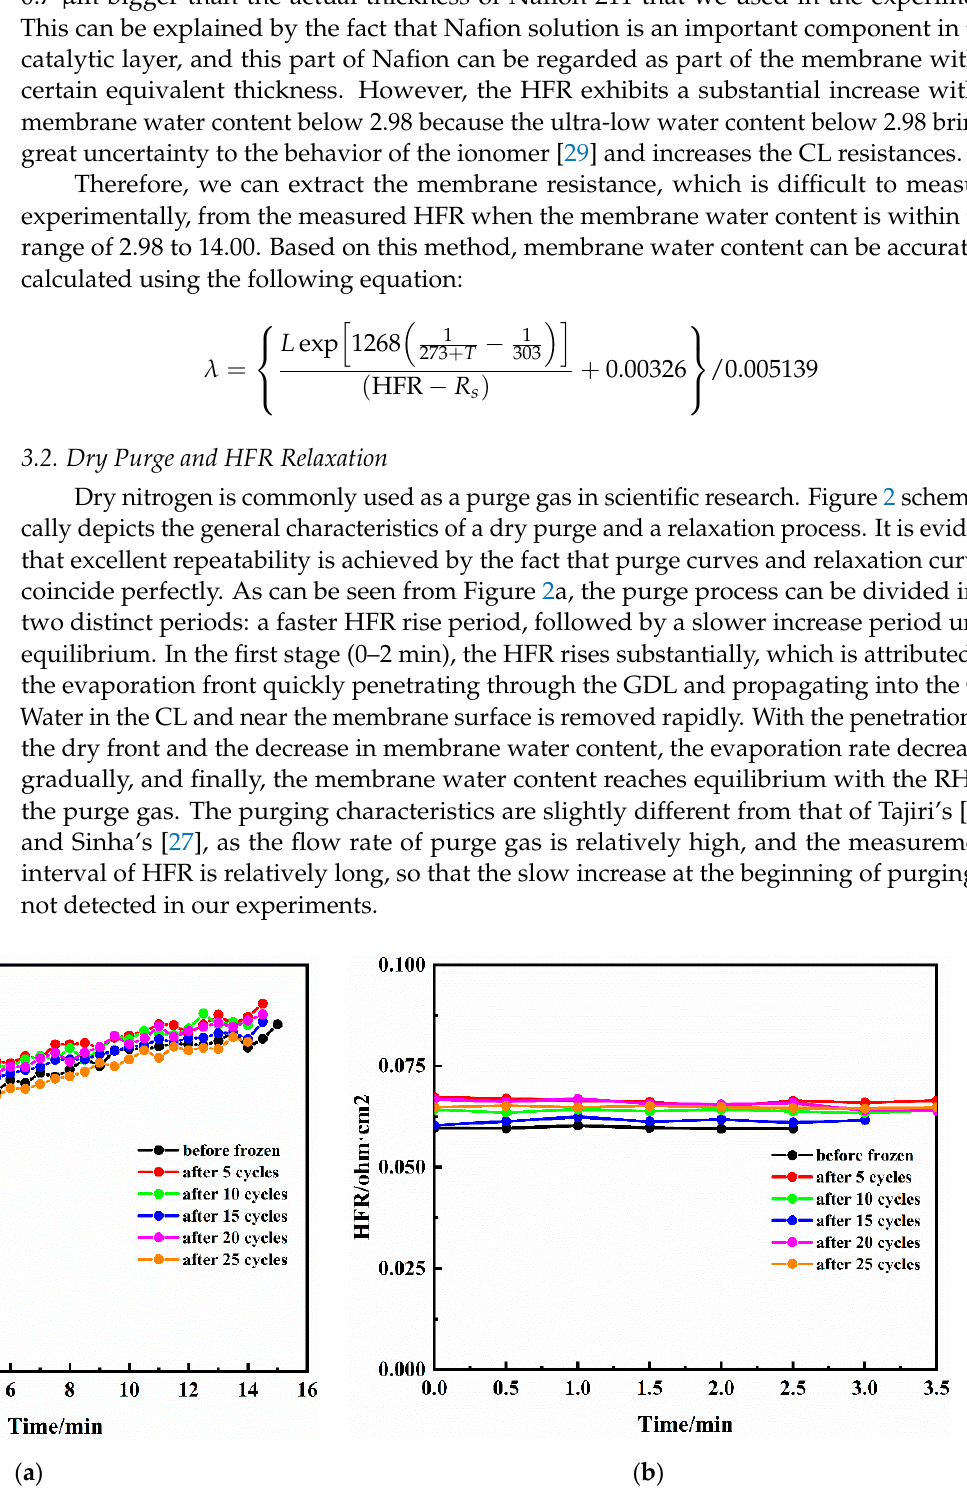
Figure 2. The HFR of cell-4: ( a ) during dry purge, and ( b ) after relaxation. After the purge was completed, the cell was sealed immediately, and the temperature was maintained at 65 °C, while the HFR gradually decreased to a constant value (as shown in Supplementary Materials, Figure S3) due to water redistribution inside the cell. The final HFR reached a stabilized value, as shown in Figure 2b. The HFR after relaxation is important, as it reflects the true membrane water content, but not the HFR during purg- ing. Therefore, we propose to use the HFR after relaxation as the direct indicator of mem- brane water content. Hence, by introducing the HFR after relaxation into Equation (7), the exact membrane water content can be calculated. It should be mentioned that membrane water content at saturation is different depending on whether the membrane is immersed in liquid water (varies from λ = 16.8 to 22.0) or exposed to water vapor ( λ = 14.0 at 30 °C with saturated water vapor) [22,23]. As for the membrane inside the cell under working conditions, the membrane is exposed to saturated reactant gases and can simultaneously absorb the liquid water produced in the cathode CL. For a conservative estimation, we set the saturated membrane water content under normal operating conditions as 14.0. There- fore, the initial membrane water content of cell-1 without purging is set as 14.0. Five cells with different membrane water content are summarized in Table 2. Table 2. Membrane water content after HFR relaxation. Cell No.